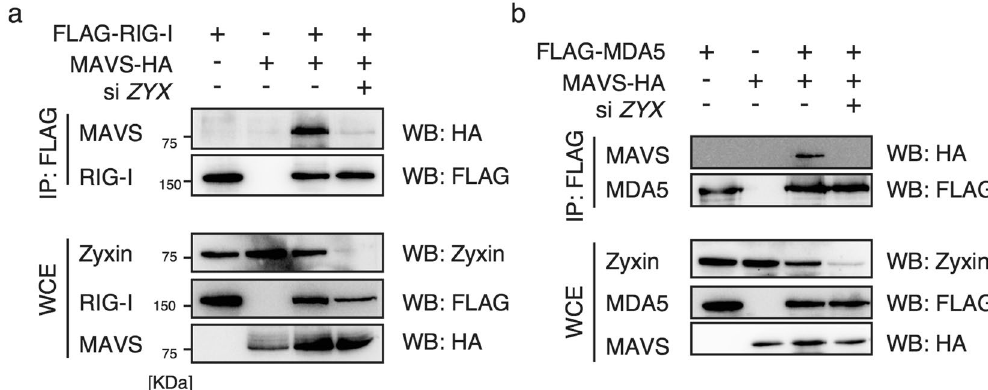
Figure 6. Zyxin stabilizes the interactions of MAVS and RLRs. ( a , b ) siRNA for negative control or ZYX were transfected into HEK293FT cells. After 48 h, cells were transfected with FLAG-RIG-I ( a ) or FLAG-MDA5 ( b ) together with a MAVS expression vector for 24 h. The cell lysates were immunoprecipitated with anti-FLAG antibody and subjected to SDS-PAGE. The proteins were detected by WB with the indicated antibodies. The original full blot images can be found in Supplemental Fig.